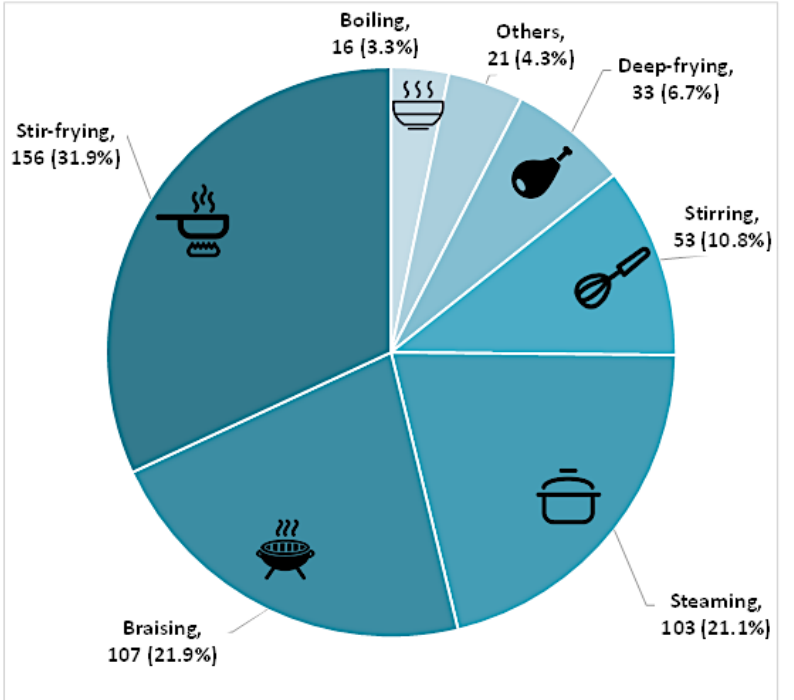
Figure 4. Example of system output: distribution of preparation methods.